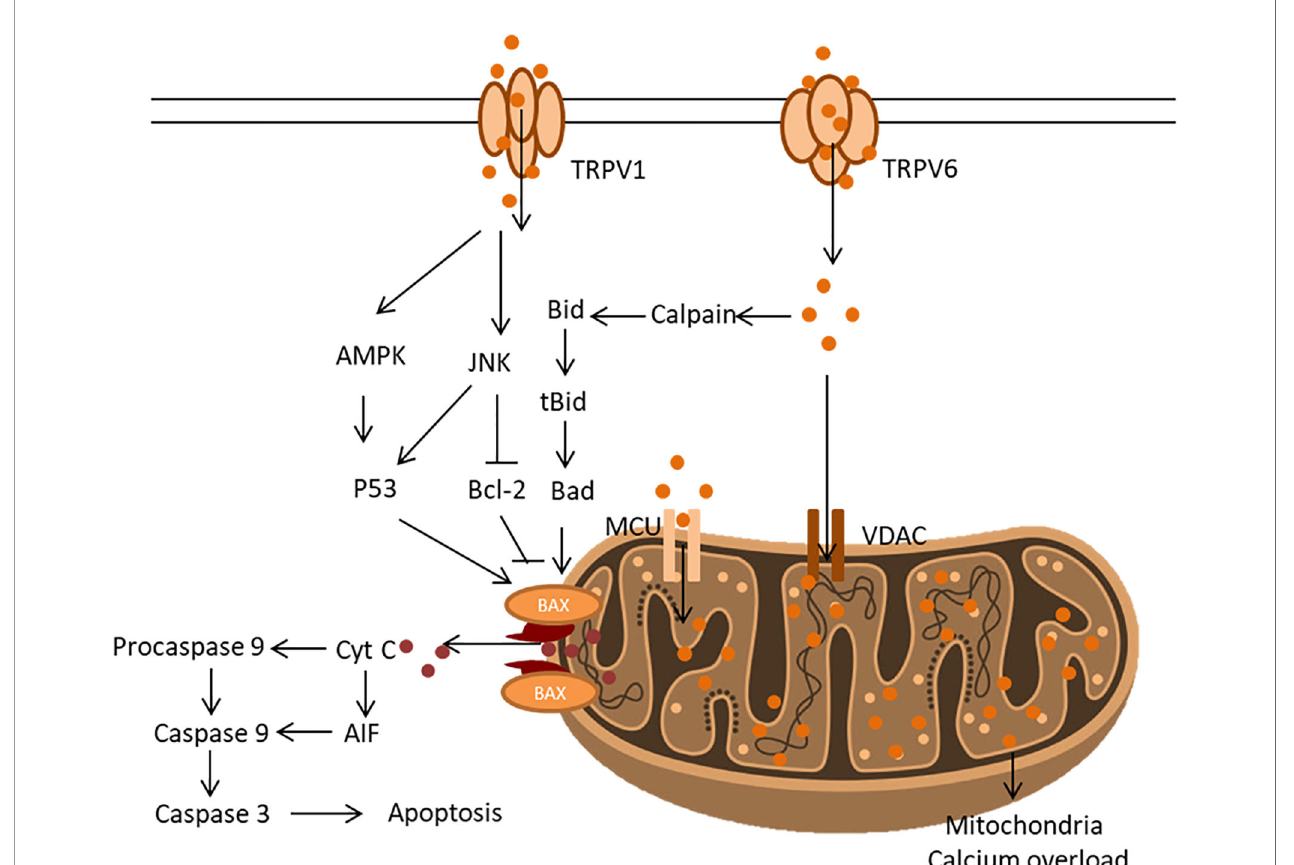
FIGURE 6 | Intracellular signalling pathway implicated in the apoptotic action of